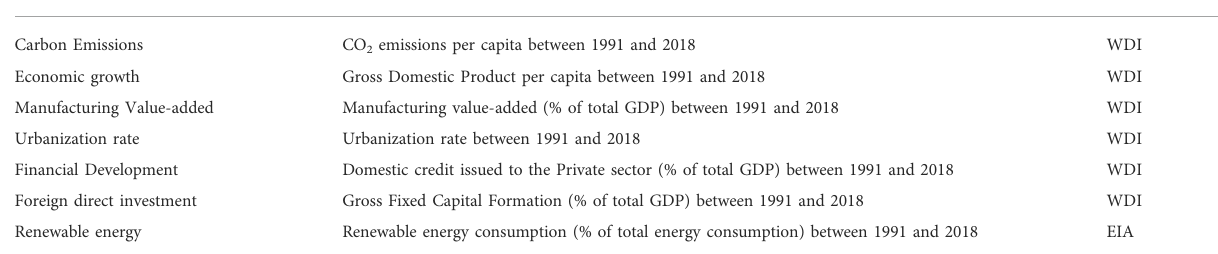
TABLE 1 De fi nition and Data source of